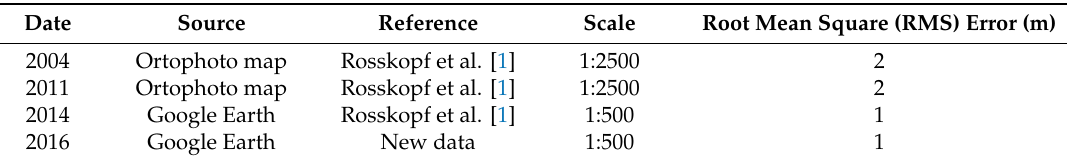
Table 1. Summary of the shoreline data.